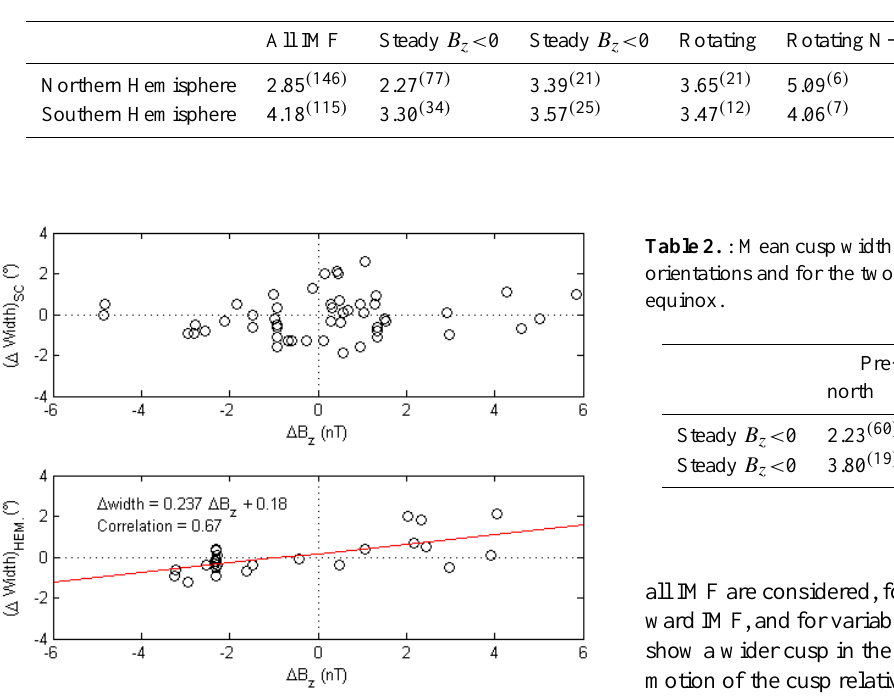
Fig. 7. Variations of the cusp width versus variations in IMF- B z . The top panel shows variations between pairs of spacecraft crossing the same cusp, whereas the bottom panel shows variations between the southern and the northern cusps on the same orbit, as well as the linear fit of the data points (in red). Only cases occurring under steady or rotating IMF are considered.